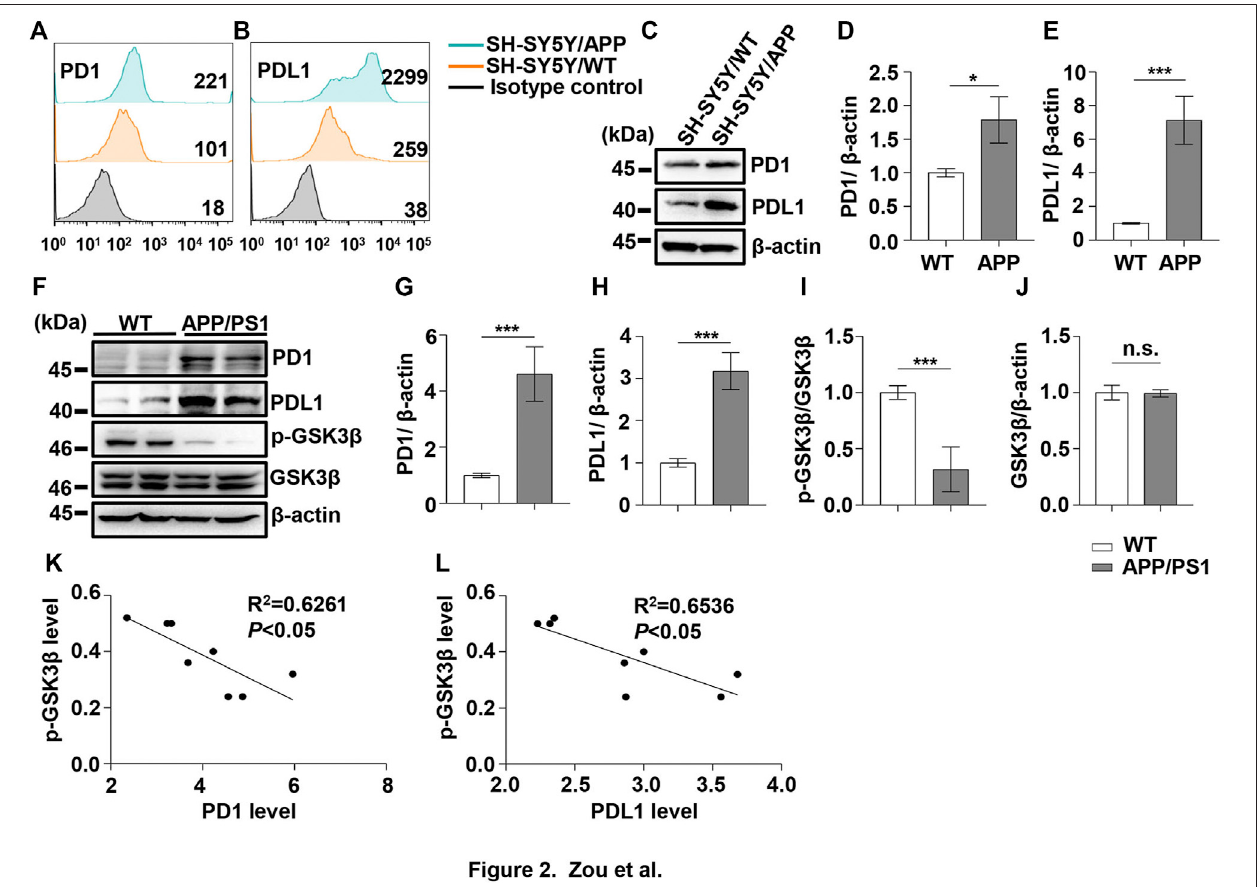
FIGURE 2 | PD1 and PDL1 levels were elevated in SH-SY5Y-APP cell line and the APP/PS1 mouse brain. Cultured SH-SY5Y and SH-SY5Y-APP cells were collectedfor fl owcytometryusingtheanti-PD1 (A) andanti-PDL1antibodies (B) . (C – E) SH-SY5YandSH-SY5Y-APPcelllysatesweresubjectedtowesternblottingwith the anti- β -actin, anti-PD1, or anti-PDL1 antibodies (*** p < 0.001, * p < 0.05; paired t -test). WT and APP/PS1 mice (male and female, average age 9 – 12 months, n (cid:2) 8/ group) were sacri fi ced and the brain tissues were harvested. (F – J) Hippocampal tissue lysates were subjected to western blotting with the anti- β -actin, anti-PD1, anti-PDL1, p-GSK3 β (Ser9), or GSK3 β antibodies (*** p < 0.001; paired t -test). (K,L) Correlation between the hippocampal p-GSK3 β (Ser9) level on the Y -axis and the corresponding PD1 or PDL1 level on the X -axis (Pearson correlation coef fi cient, R 2 (cid:2) 0.6261, p < 0.05, or R 2 (cid:2) 0.6536, p < 0.05, respectively). n.s., p > 0.05. Data are representative of three independent